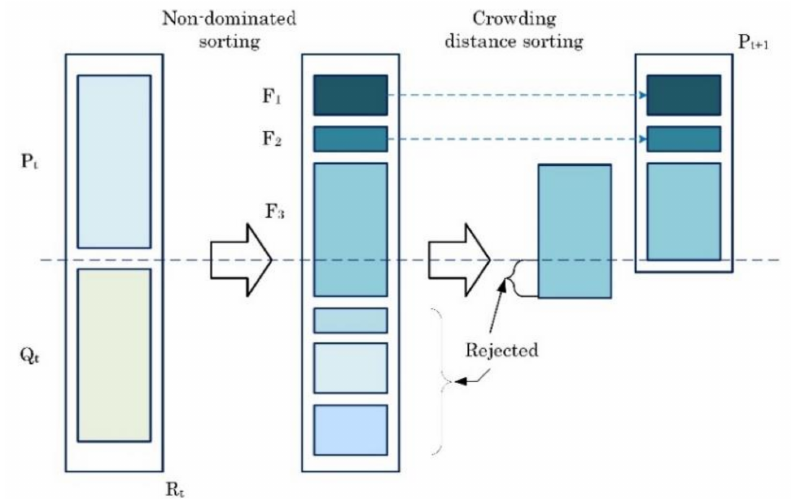
Figure 8. Schematic of NSGA-II